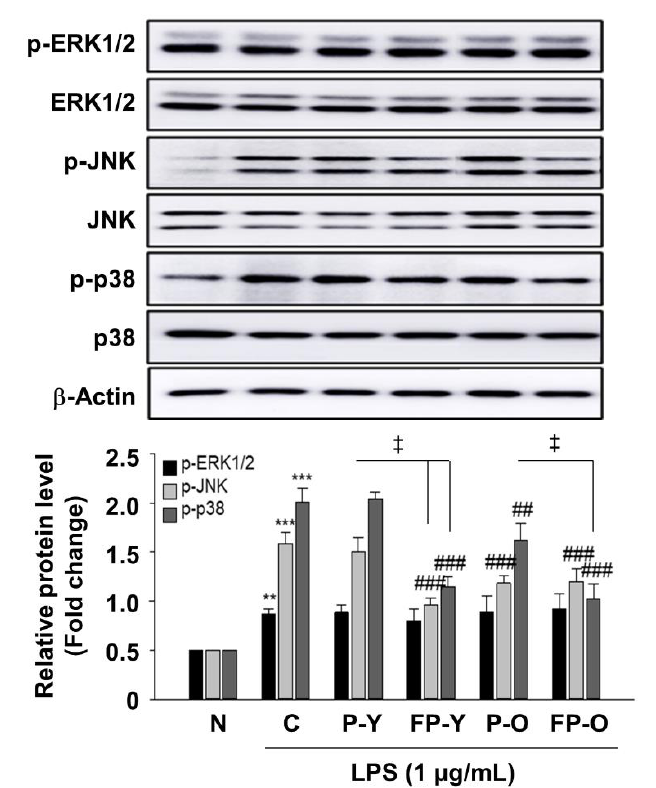
Figure 7. Effect of FP on LPS-induced MAPKs activation in RAW 264.7 macrophages. Levels of phosphorylated ERK1/2, JNK, and p38 were assessed by immunoblot analysis. β-Actin was used as a loading control. Each band was densitometrically quantified by image analysis. ** p < 0.01, *** p < 0.001 vs. N; ## p < 0.01, and ### p < 0.001 vs. C; ‡ p < 0.01 vs. P-Y or P-O. Values are means ± SEM. Significant differences between the groups were determines by ANOVA followed by Duncan’s multiple range test. LPS, Lipopolysaccharides; N, Normal; C, Control; P-Y, Yellow Paprika; P-O, Orange Paprika; FP-Y, Fermented P-Y; FP-O, Fermented P-O.